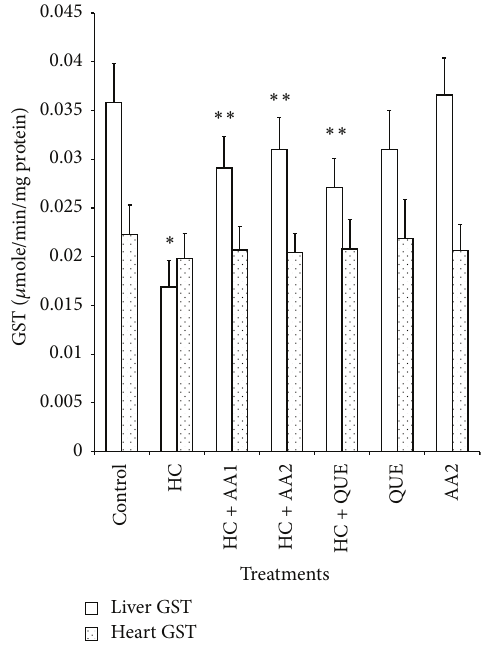
Figure 5: Effects of methanol extract of Artocarpus artilis on the activities of hepatic and cardiac glutathione-s-transferase (GST) of hypercholesterolemic rats. ∗ Significantly different from control ( 𝑃 < 0.05 ), ∗∗ significantly different from HC ( 𝑃 < 0.05 ). HC: hypercholesterolemic rats, AA1: Artocarpus altilis at 100 mg/kg, AA2: Artocarpus altilis at 200 mg/kg, and QUE: Questran at 0.26 g/kg.